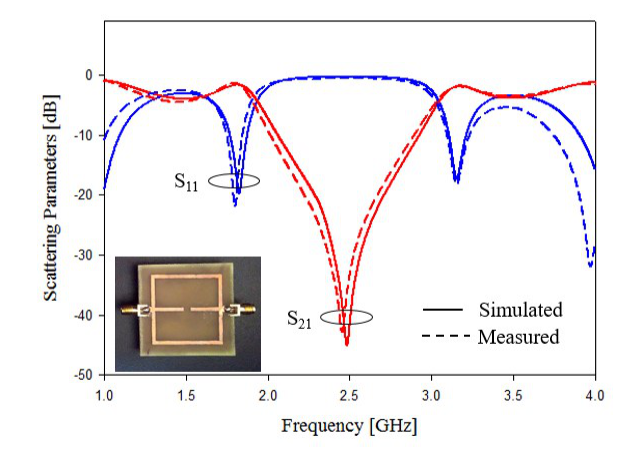
Figure 13. Experimental assessment, prototype of Figure 11b. Comparisons between numerical and measured scattering parameters.